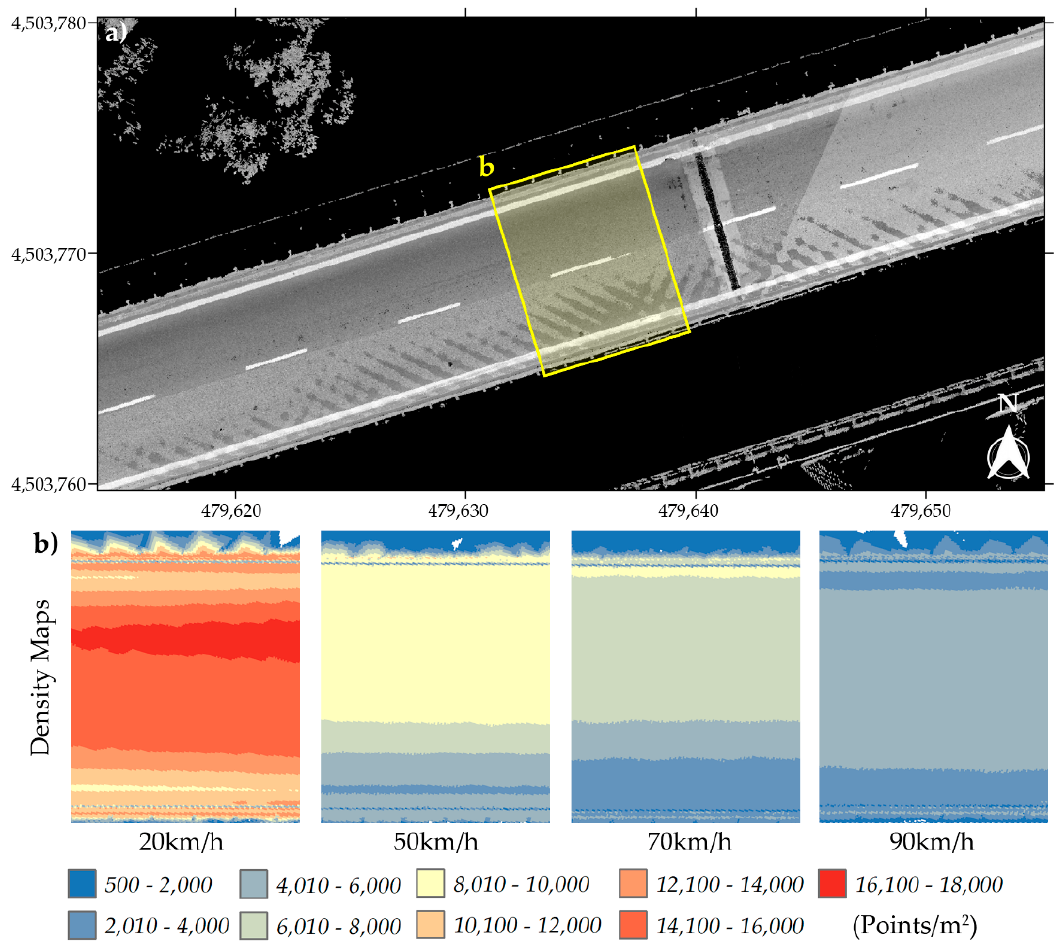
Figure 4. Density map. ( a ) Top view of the excerpt of the point cloud of the single carriageway, the color scale is a function of the intensity values; ( b ) density maps at different average velocities (20, 50, 70, 90 km/h).